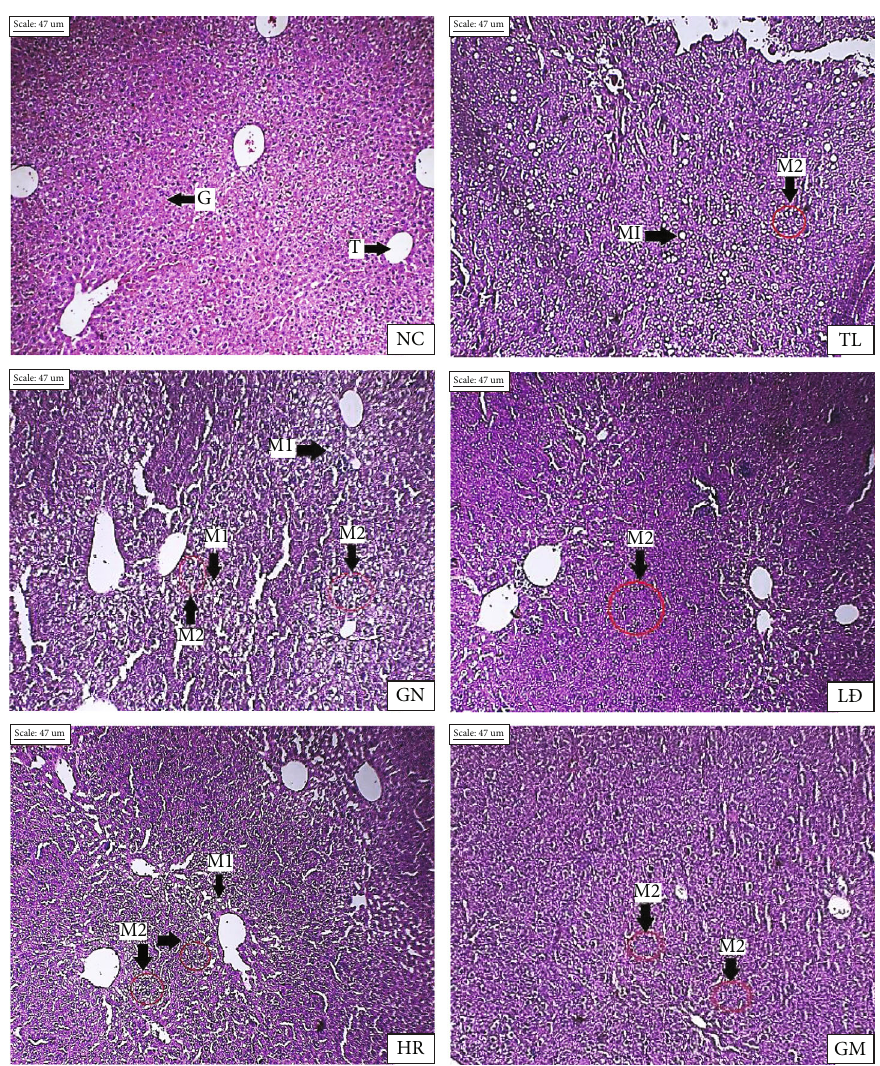
Figure 4: Photomicrographs of white adipose tissue ( × 100). (T: central vein; G: hepatocytes; M1: macrosteatosis; M2: